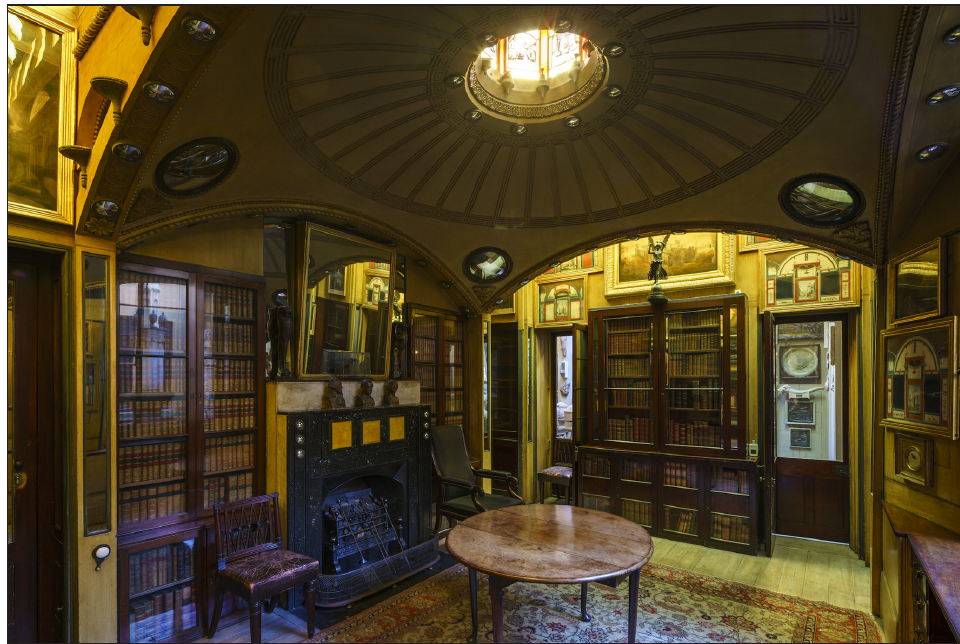
Fig. 6 : View of the breakfast room looking north-west. © Sir John Soane’s Museum. Photo: Gareth